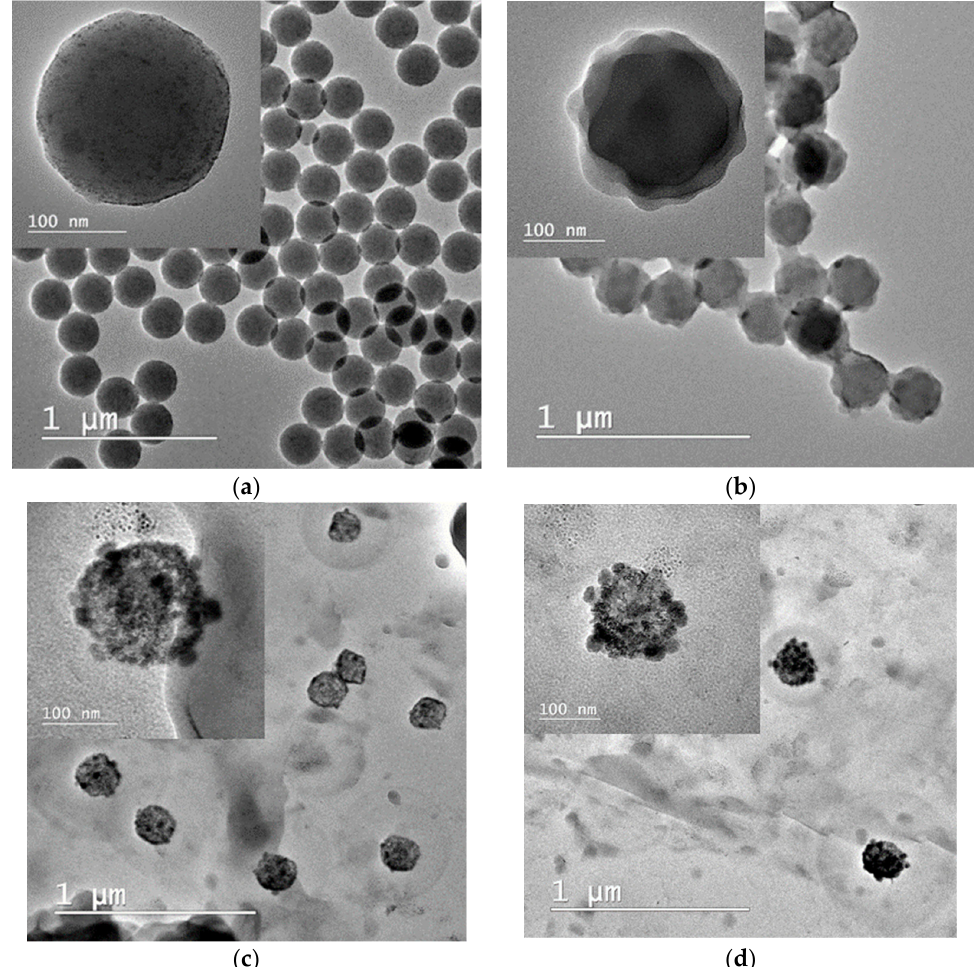
Figure 1. TEM images of the samples: ( a ) ST-HEMA; ( b ) ST-HEMA-GMA; ( c ) ST-HEMA-GMA-BCD-NH 2 and ( d ) ST- HEMA-GMA-BCD-OH. NH 2 and ( d )